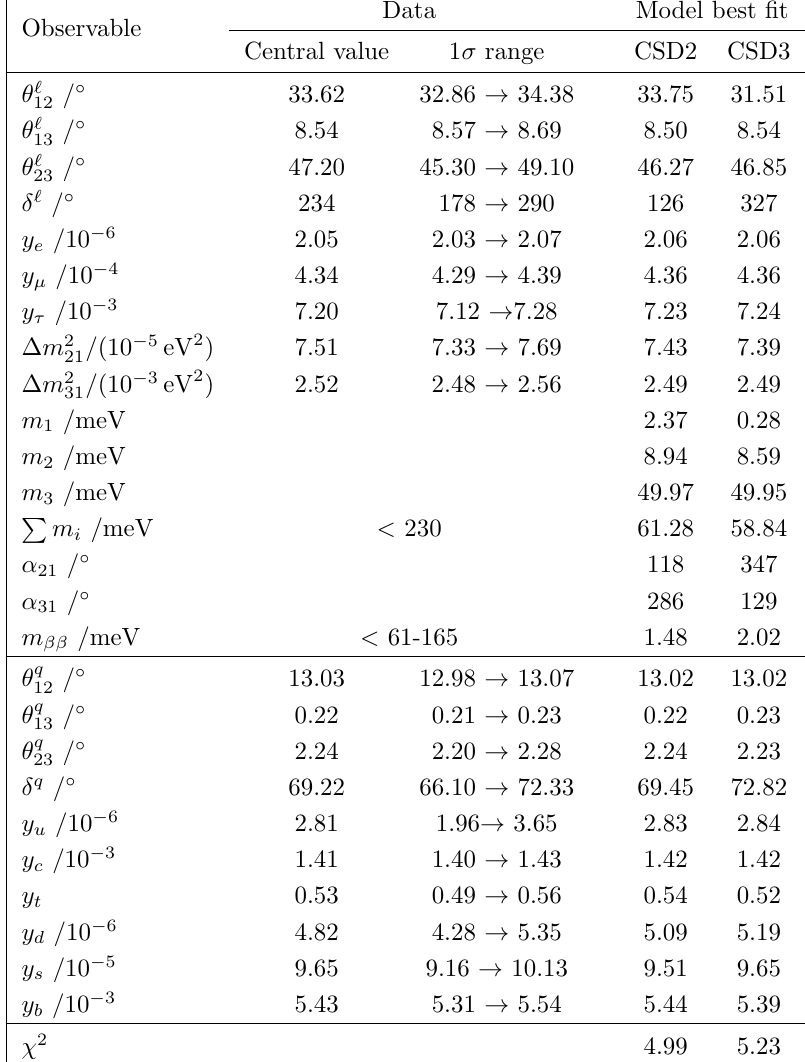
Table 2 . Flavour observables from experiments compared to the predictions of the model discussed in the main text, based on CSD3 vacuum alignment, as well as for an alternative CSD2 vacuum alignment discussed in appendix B. The quark masses, charged lepton masses and CKM parameters come from [63]. The neutrino observables come from [64]. The (cid:12)ts have been performed using the Mixing Parameter Tools (MPT) package. The SUSY breaking threshold corrections are assumed to be: tan (cid:12) = 10 ; (cid:22) (cid:17) b = (cid:0) 0 : 9 ; (cid:22) (cid:17) q = 0 : 4 ; (cid:22) (cid:17) l = 0 :